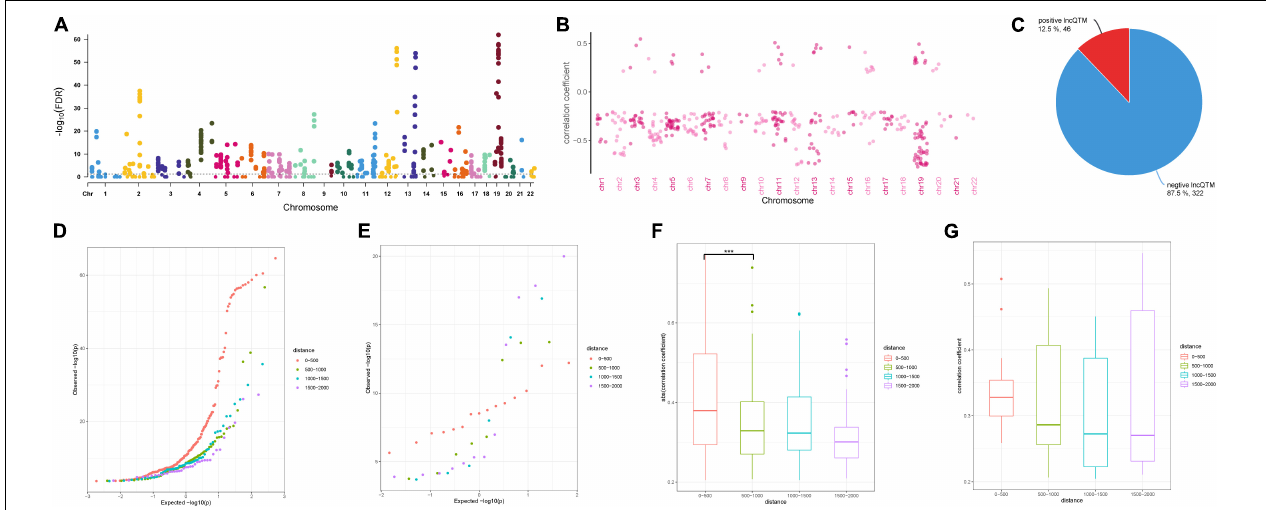
FIGURE 2 | Character of lncQTMs in colon cancer. (A) Manhattan plot methylation-lncRNA FDR values in each chromosome (Spearman’s rank correlation test). The horizontal dotted line indicates the significant cut-off (FDR = 0.05) of lncQTMs. (B) Distribution of correlation coefficient of lncQTMs in each chromosome. (C) The number of positive and negative LncQTMs. (D) Quantile-Quantile Plot of negative lncQTMs for each distance category. (E) Quantile-Quantile Plot of positive lncQTMs for each distance category. (F) Boxplot of negative lncQTMs correlation coefficient relative to different distance. (G) Boxplot of positive lncQTMs correlation coefficient relative to different distance. ***Denote p <